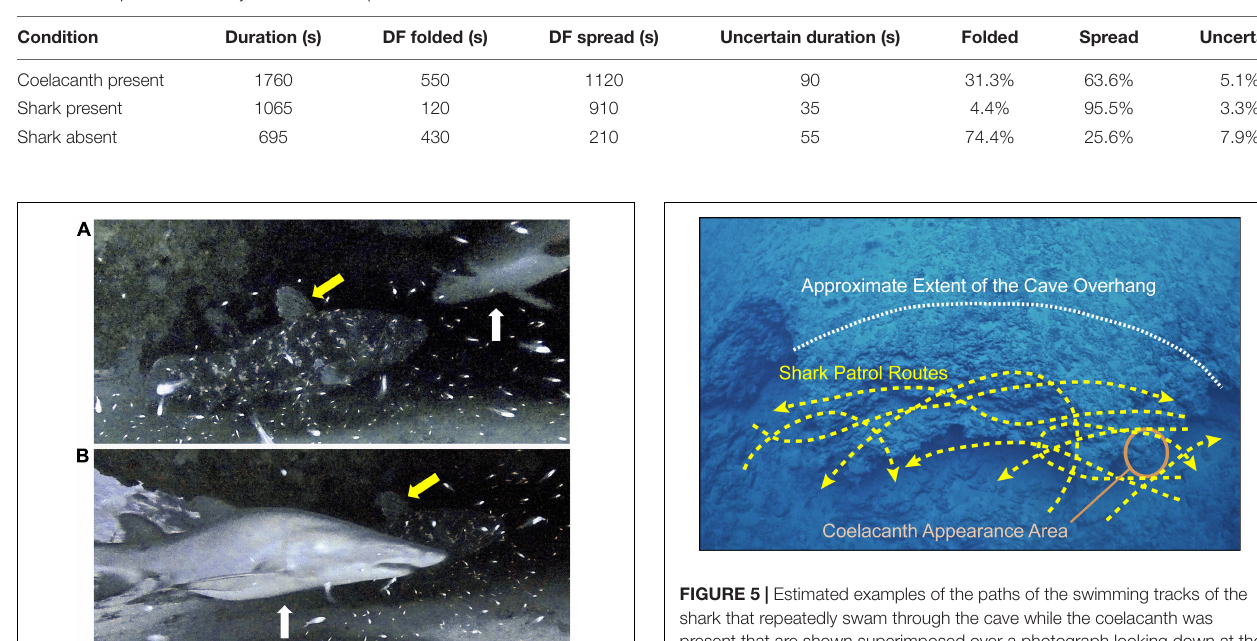
TABLE 1 | The amount of time that the first dorsal fin (DF) of a coelacanth, Latimeria chalumnae , was in the folded or spread states during the observations made in the cave at the top of Jesser Canyon in relation to presence or absence of a shark.